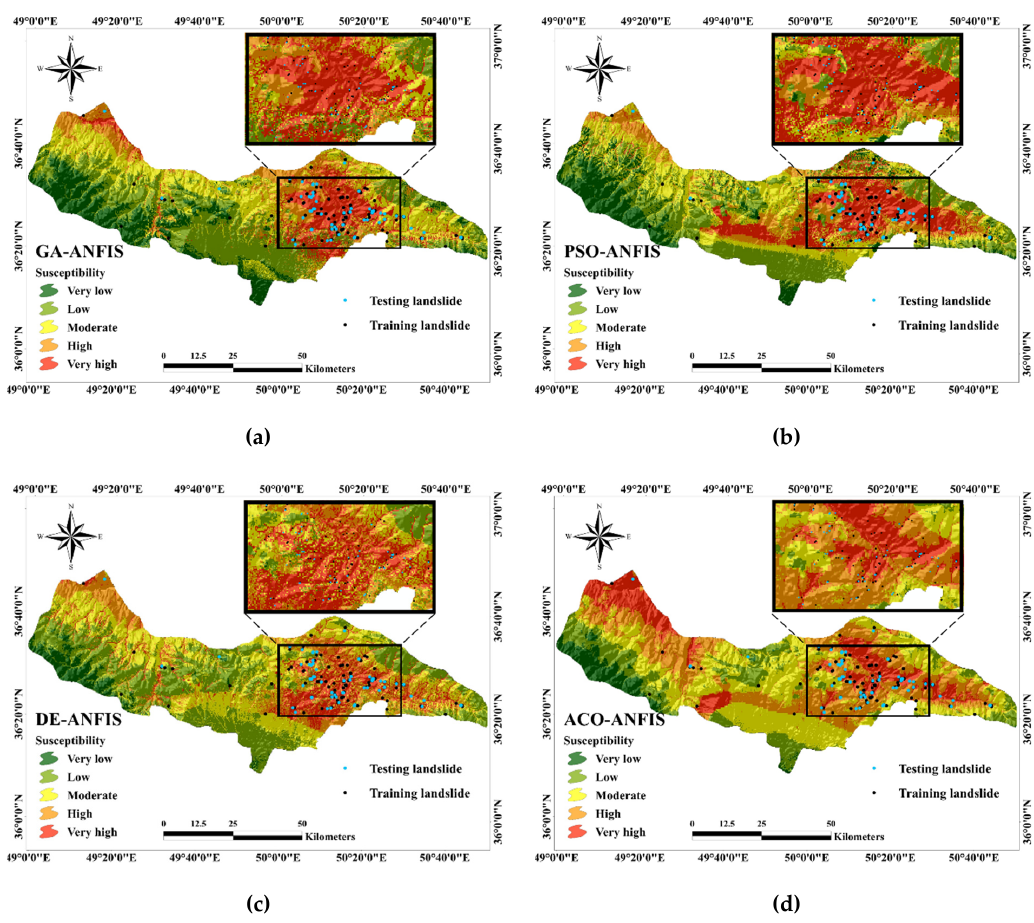
Figure 7. Generated landslide susceptibility maps for (a) GA-ANFIS, (b) PSO-ANFIS, (c) DE-ANFIS, (d) ACO-ANFIS.